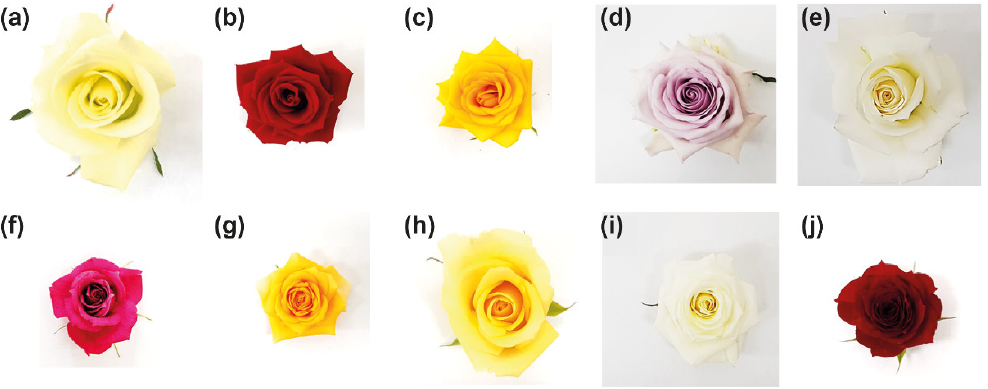
Figure 1. Photos of each variety of roses selected for the experiment. Standard type: ( a ) ‘Green Star’, ( b ) Red Square’, ( c ) ‘Shooting Star’, ( d ) ‘Mystic Blue’, ( e ) ‘Tineke’; spray type: ( f ) ‘A-Pink’, ( g ) ‘Sunny Lady’, ( h ) ‘Ever Spring’, ( i ) ‘Vivien’, ( j ) ‘Red Pop’.